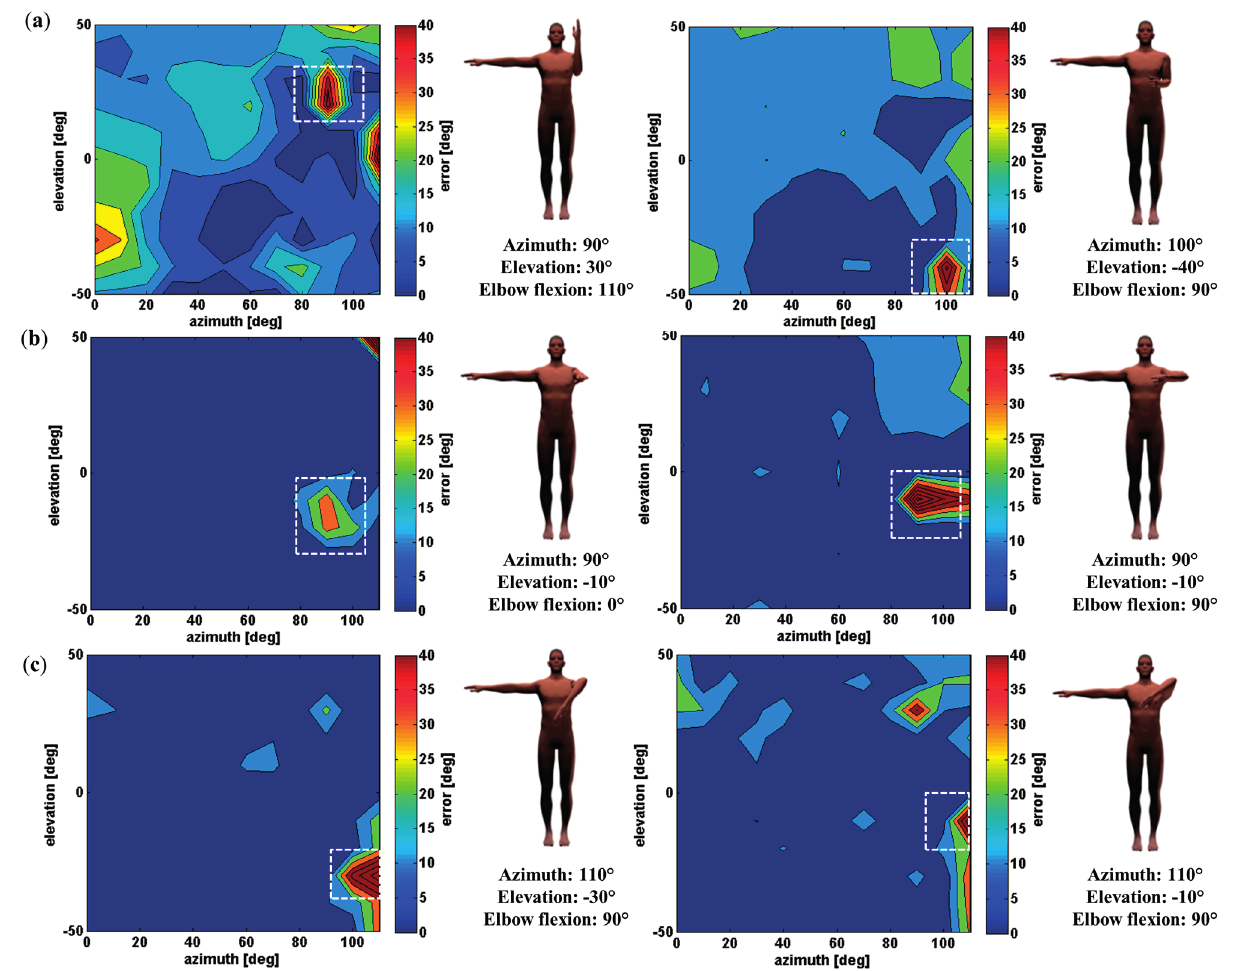
Figure 7. Example of misestimated poses with a Kinect placed in front of the subject for the shoulder joint (left column) and the elbow joint (right column). Dotted squares show the graphic areas selected. ( a ) Swivel angle at 0°; ( b ) Swivel angle at 90°; ( c ) Swivel angle at